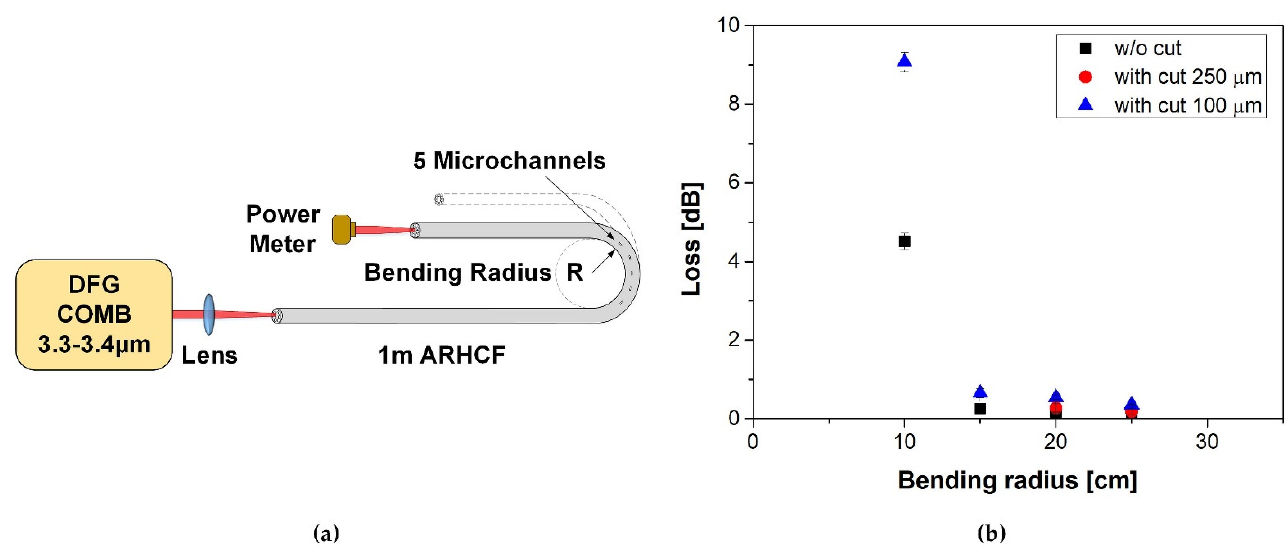
Figure 10. Bending loss of the ARHCF with microchannels: ( a ) schematic of the measurement setup and ( b ) results of measurements plotted as a function of the bending radius.